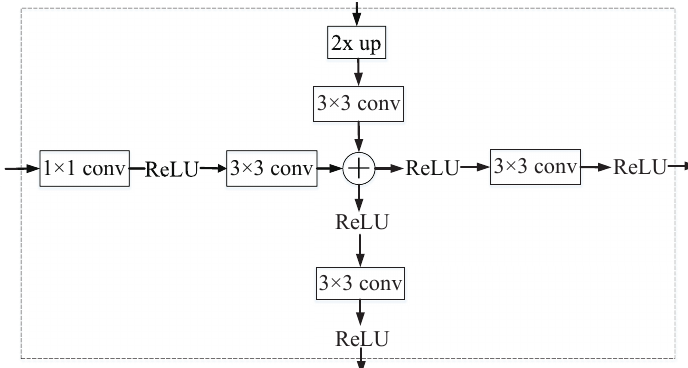
Figure 4. The building block of refine feature pyramid network. The ⊕ denotes element-wise